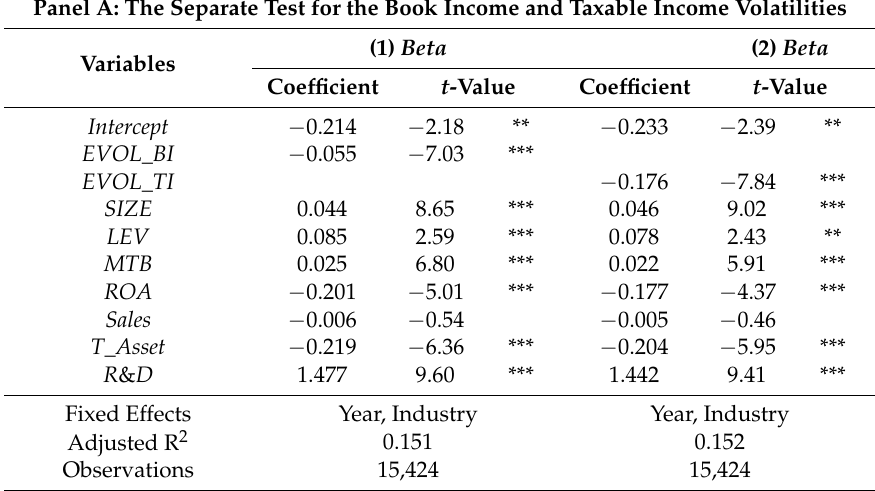
Table 5. The relevance of earnings volatilities to the market beta of stock returns. Panel A: The Separate Test for the Book Income and Taxable Income